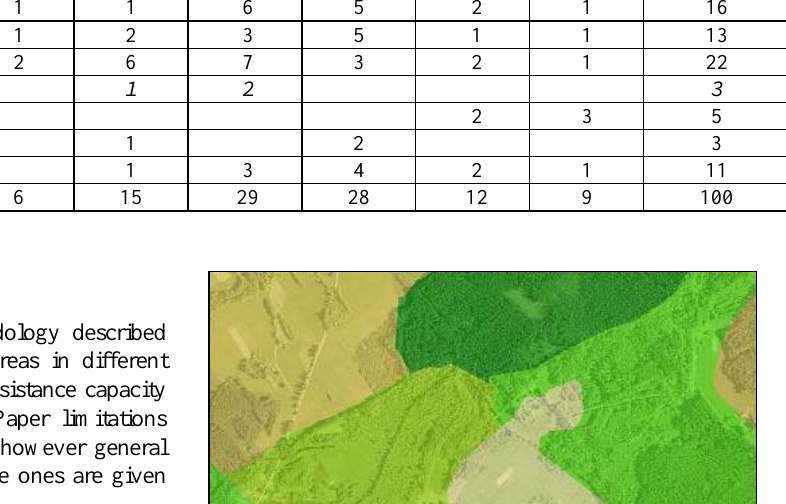
Clayey downy plateaus